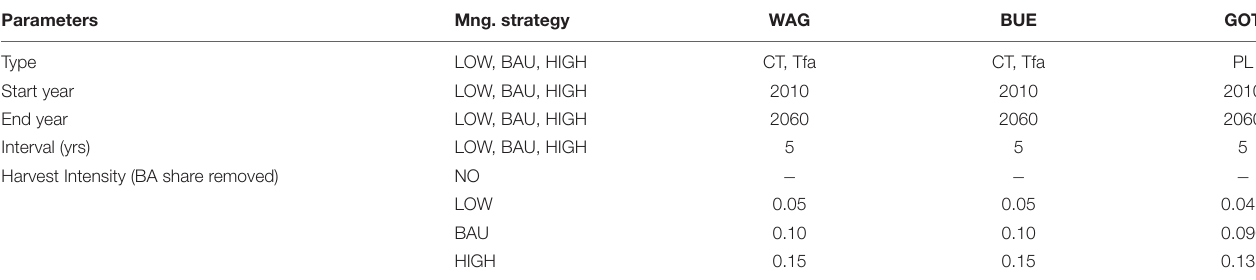
TABLE 2 | Settings for the four alternative management strategies applied at the three case study enterprises WAG, BUE and GOT (NO: no management, LOW: low intensity, HIGH: high intensity, BAU: business as usual, representing current management). Parameters Mng. strategy WAG BUE GOT